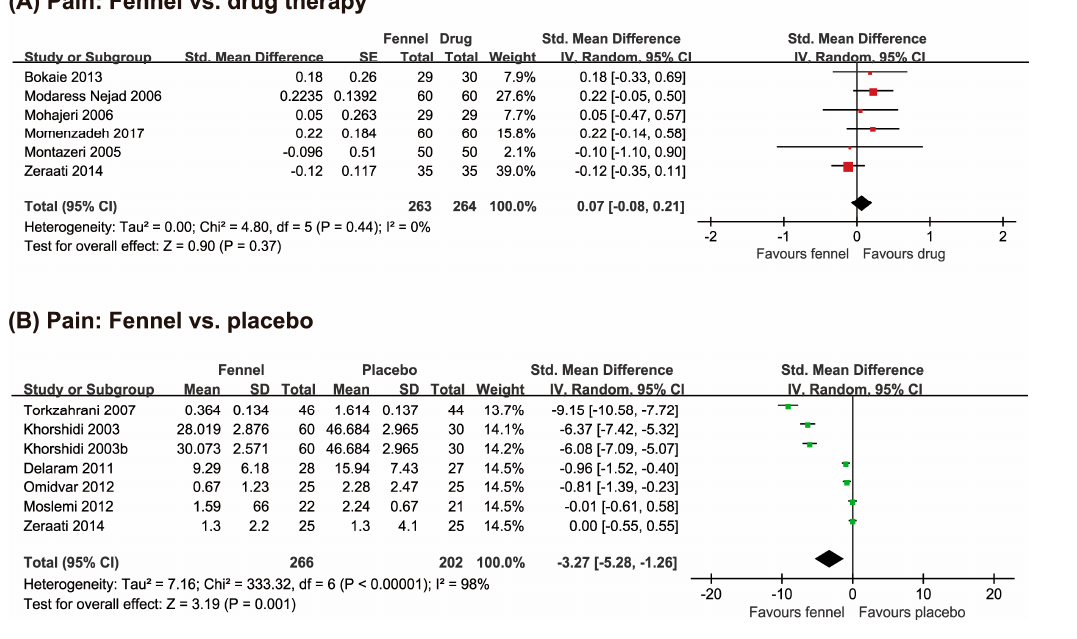
Figure 3. Forest plot of effects of fennel on menstrual pain compared with ( A ) drug therapies and ( B ) placebo. CI: confidence interval; SD: standard mean difference.